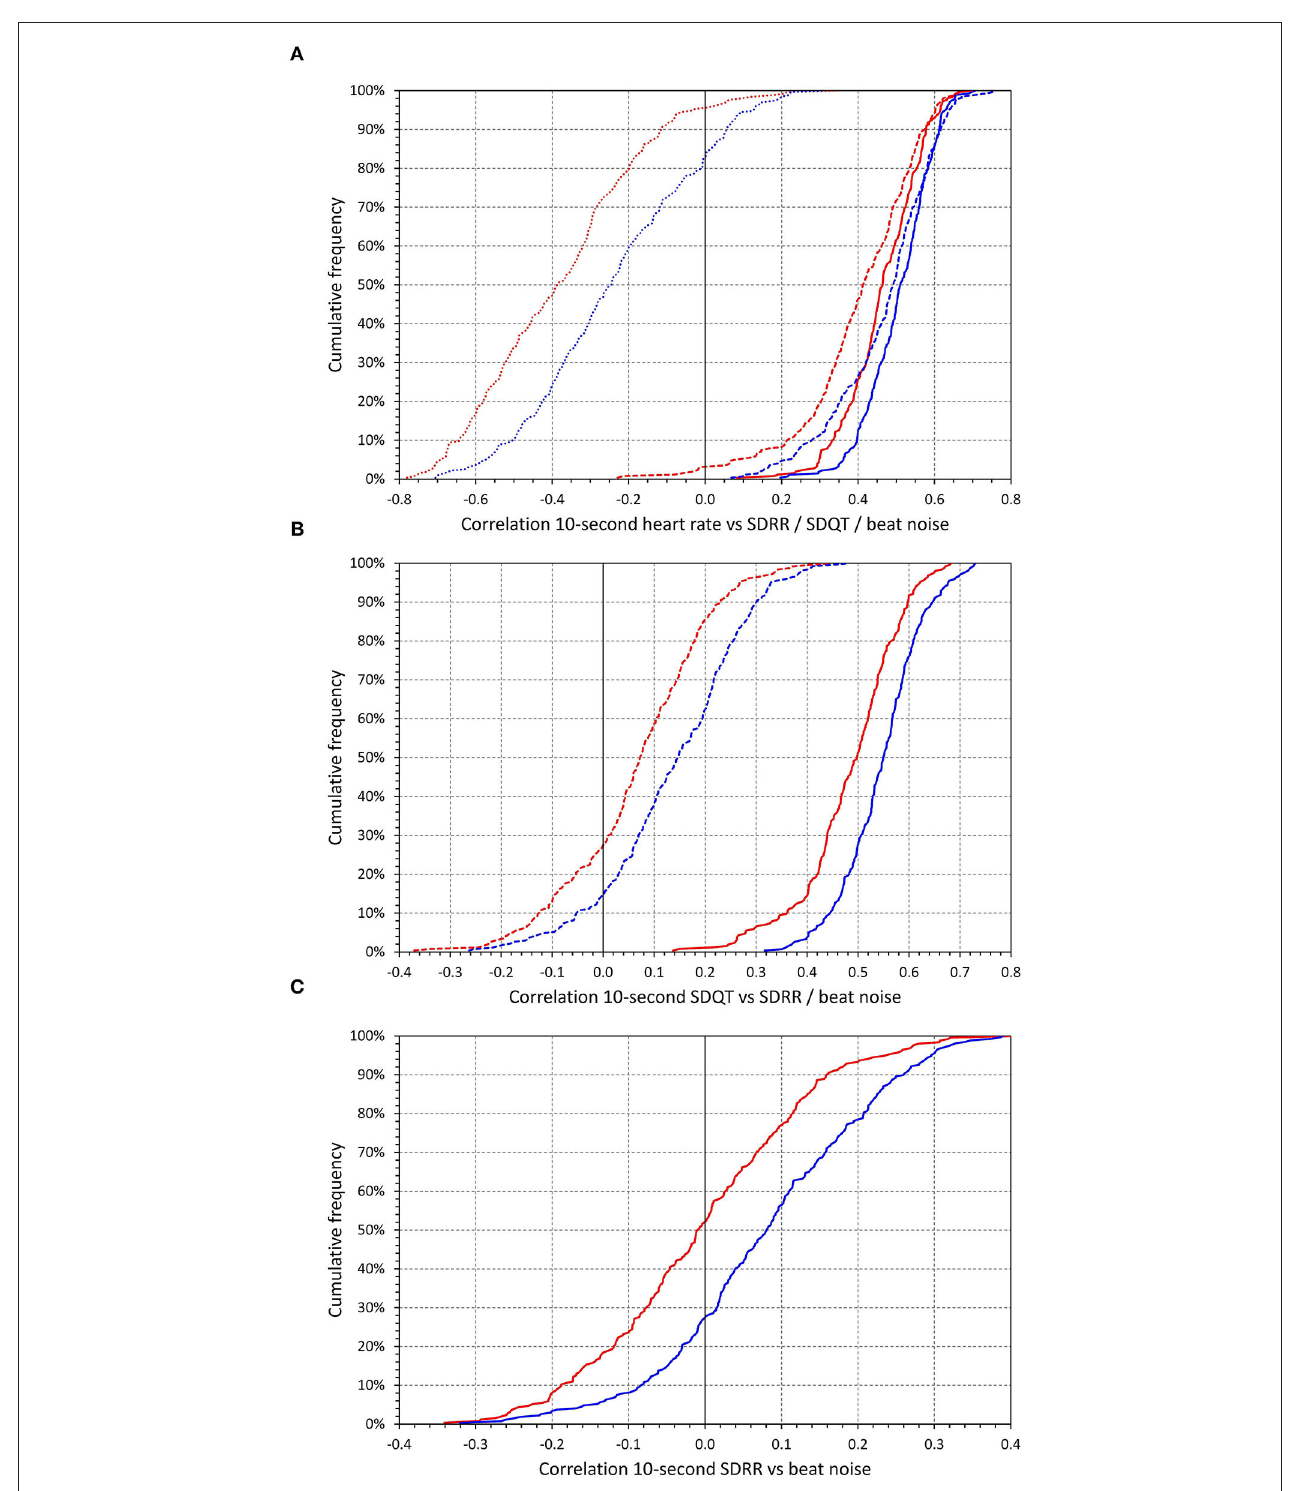
FIGURE 9 | The top (A) shows cumulative distributions of intra-subject correlations between 10-s heart rate and 10-s median beat noise (solid lines), intra-subject correlations between 10-s heart rate and 10-s SDQT (dashed lines), and intra-subject correlations between 10-s heart rate and 10-s SDRR (dotted lines). The middle (B) shows cumulative distributions of intra-subject correlations between 10-s SDQT and 10-s median beat noise (solid lines) and intra-subject correlations between 10-s SDQT and 10-s SDRR (dashed lines). The bottom (C) shows cumulative distributions of intra-subject correlations between 10-s SDRR and 10-s median beat noise. In each panel, the red and blue lines show the distributions in females and males, respectively.